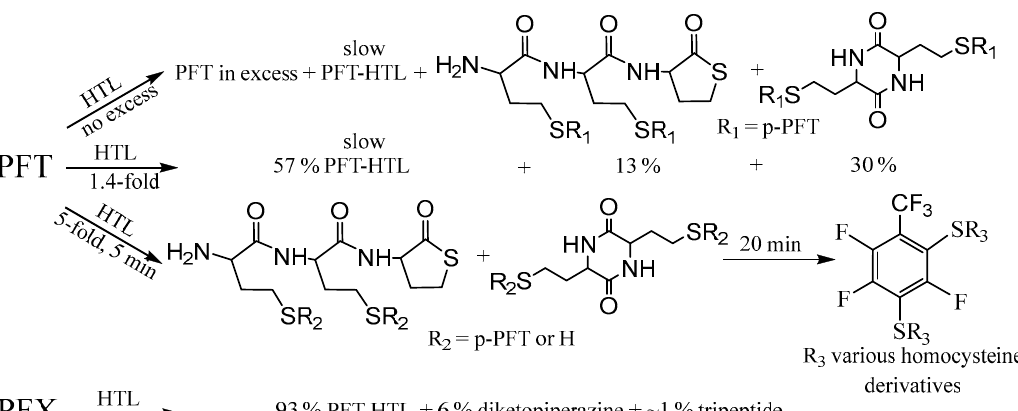
Figure 3. HTL-free base reaction with PFT and PFX in various ratios. The PFT:HTL ratios are 1:1 (line 1), 1:1.4 (line 2), and 1:5 (line 3). Line 4 PFX:HTL ratio is 1:1.4. (line 1), 1:1.4 (line 2), and 1:5 (line 3). Line 4 PFX:HTL ratio is